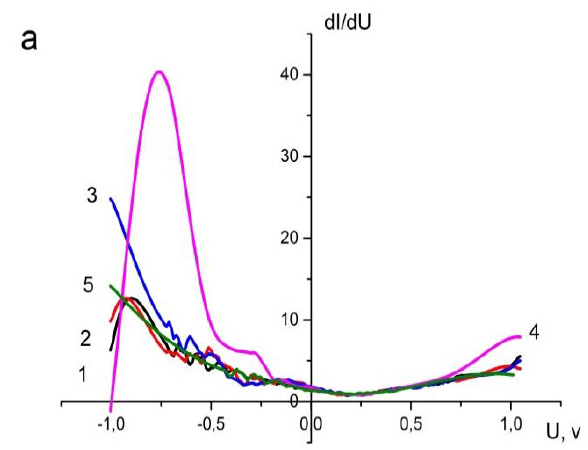
corresponding dependencies of differential conductance versus applied voltage are presented in Fig. 3a and 3b.